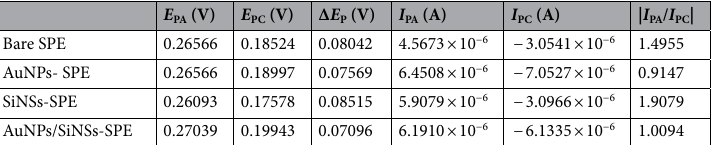
Table 1. Electrodynamics data about anodic peak potential (E PA ), cathodic peak potential (E PC ), potential difference (∆E p ), anodic peak current (I PA ), cathodic peak current (I PC ) and anodic to cathodic peak current ratio (I PA /I PC ) of HexaFc with different surface-modified working